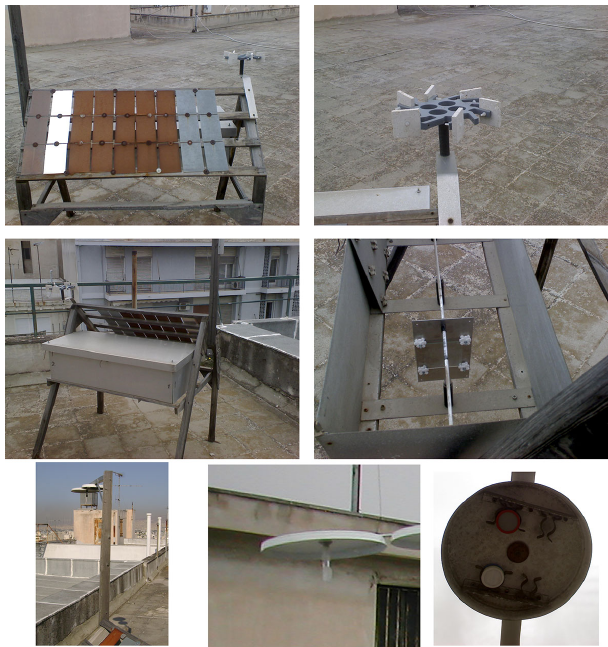
Figure 1. The exposure site in the centre of Athens (Greece). The top panel shows the carousel (on the right) and the main rack (on the left) with the material specimens. They consisted of an inclined plane and an aluminium box with open bottom (middle panel). The middle panel shows aluminium box (on the left) and the glass specimens inside the aluminium box (on the right). The bottom panel shows the diffusive passive samplers for the surface air pollu- tants measurements and the passive particle collector under the rain